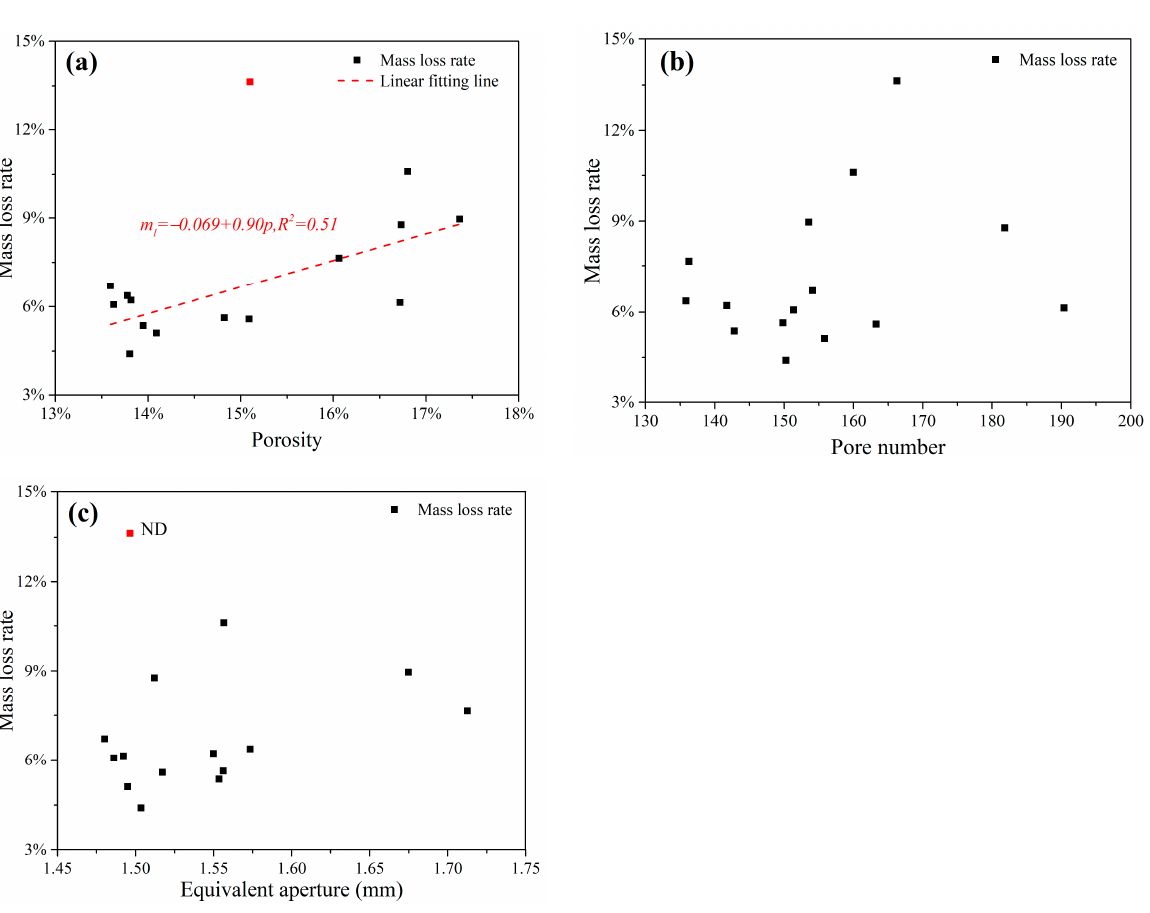
Figure 13. The relationship between the mass loss rate and pore characteristics: ( a ) porosity; ( b ) pore number; ( c ) equivalent aperture.